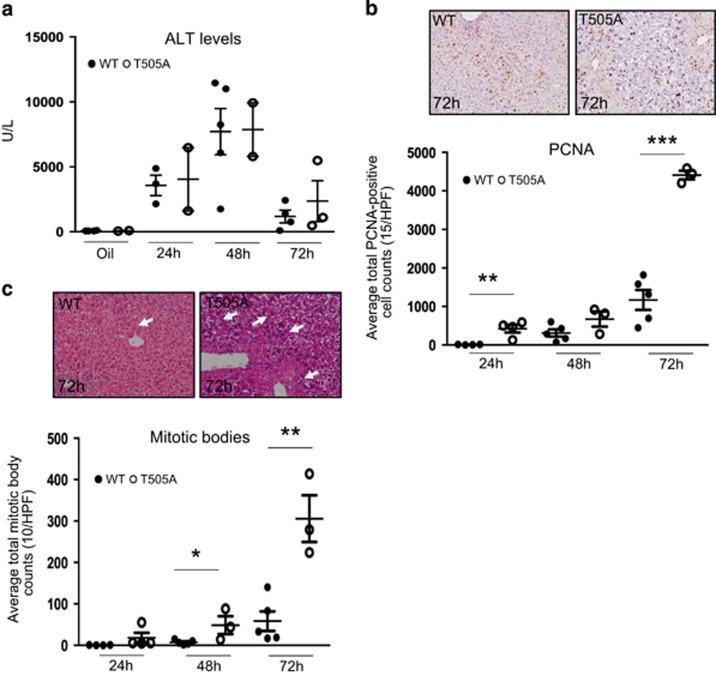
Increased hepatocyte proliferation in RelA T505A mice following acute CCl4 administration. (a–c) Serum transaminase, alanine aminotransferase measurements in arbitrary units/litre (U/L) (a), mean number of cells/field scoring positive for PCNA (b), and mitotic bodies (c) in WT and T505A liver tissue sections following acute CCl4 administration. Representative images of each are shown. Photomicrographs are at × 200 magnification. *P<0.05, **P<0.01, ***P<0.001 (Unpaired Student's t-test).